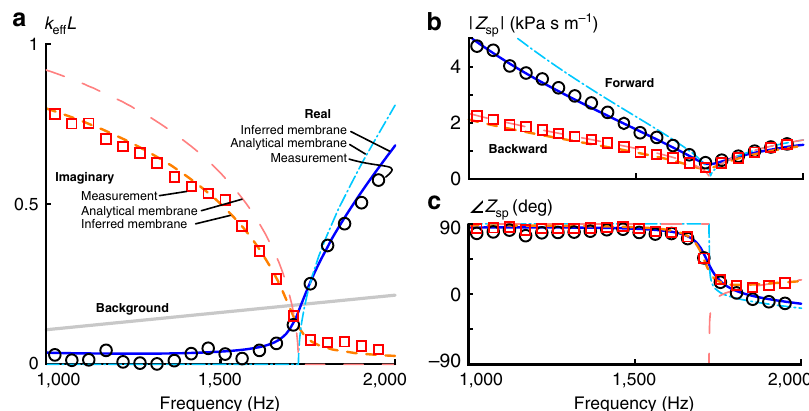
Figure 6 | Measured and predicted effective wavenumber and specific acoustic impedance. The effective wavenumber is shown in a , whereas the magnitude of the effective specific acoustic impedance and the associated phase in the forward and backward orientations is shown in b , c , respectively. The labelling of the line styles in a also hold for b , c . There appears to be a critical frequency, which is about 1,720Hz. The effective wavenumber is almost entirely imaginary below this critical frequency and is almost entirely real above the critical frequency. The magnitude of the specific acoustic impedance is different for the two orientations below the critical frequency, but converge at a minimum value and increase nearly identically above the critical frequency. The phase of the specific acoustic impedance, on the other hand, is nearly 90 (cid:2) for both orientations well below the critical frequency, drops to about 0 (cid:2) at the critical frequency and splits symmetrically about zero based on orientation above the critical frequency. The splitting of the phase of the specific acoustic impedance based on orientation is indicative of the effect of Willis coupling on the specific acoustic impedance of the